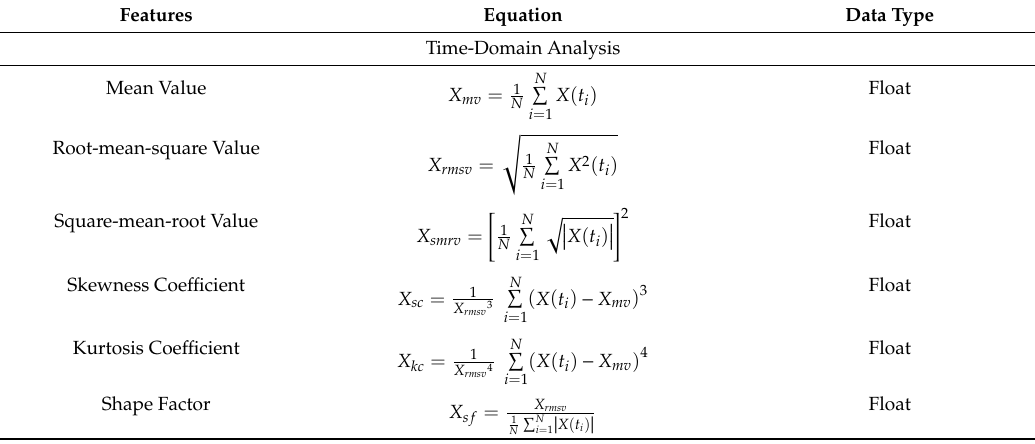
Table 3. Eight Statistical Features of MSTV.